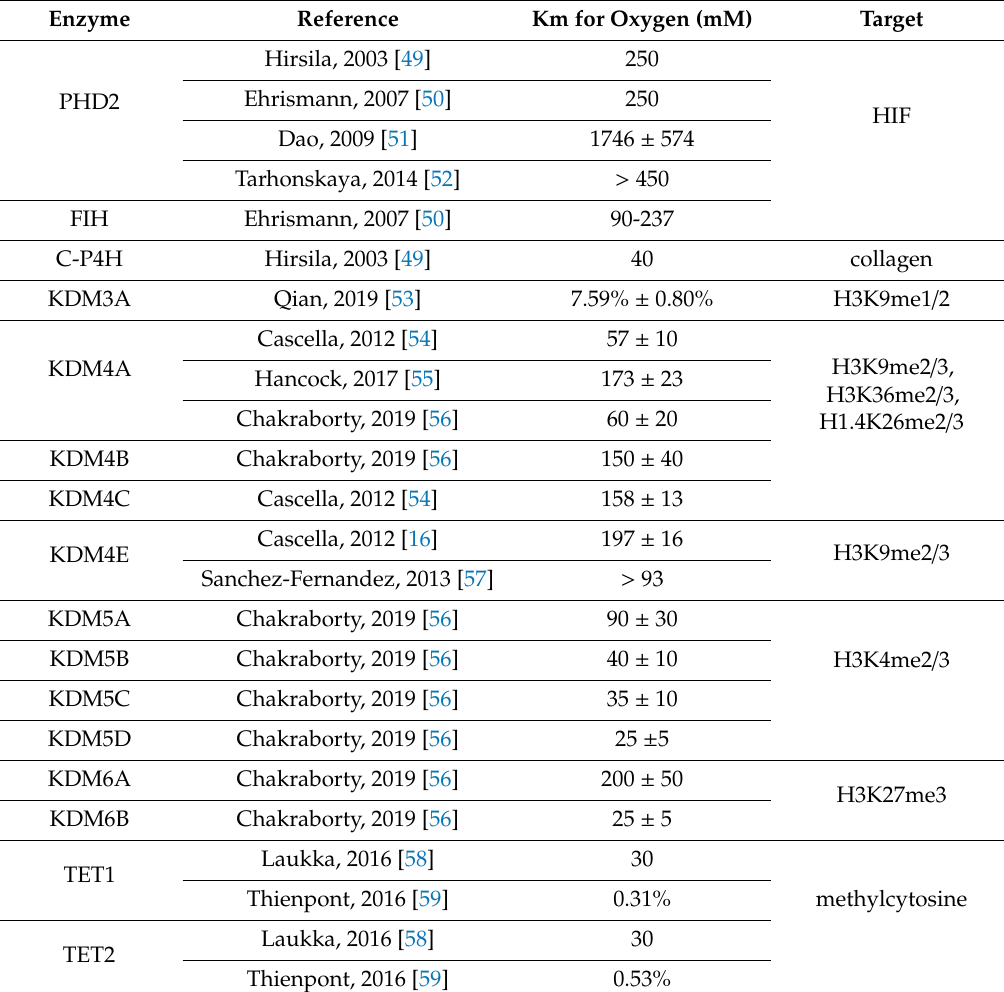
Table 1. Sensitivity of 2-oxoglutarate-dependent dioxygenases to oxygen. 2-OG dependent dioxygenases that have been shown to have histone and DNA modifying activities, the targets they modify, and their sensitivity to changes in oxygen